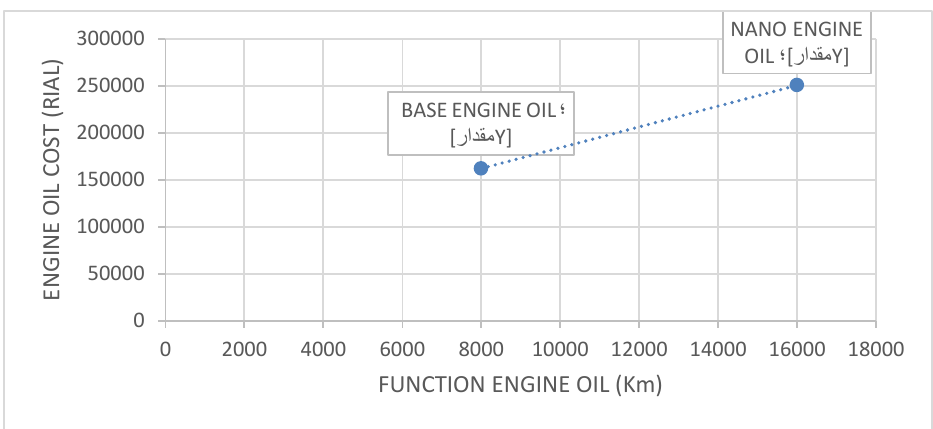
Figure3. Comparing cost and performance of Nano engine